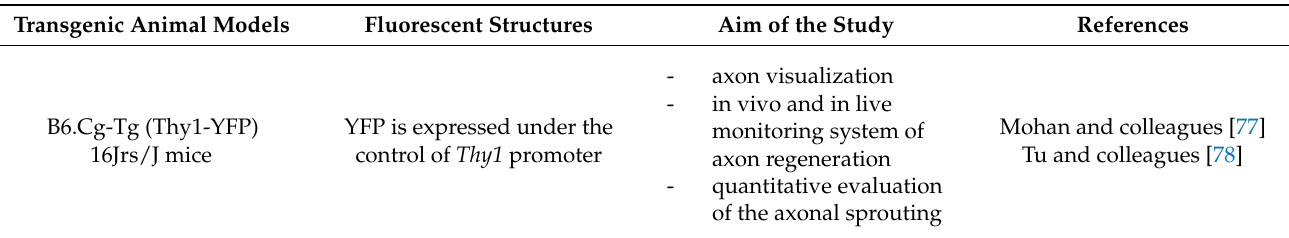
Table 3. Transgenic animal models for the morphological analysis of nerve fibers. Transgenic Animal Models Fluorescent